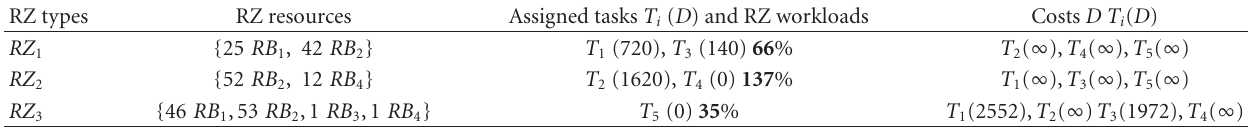
Table 1: Example of final results of Step 2.